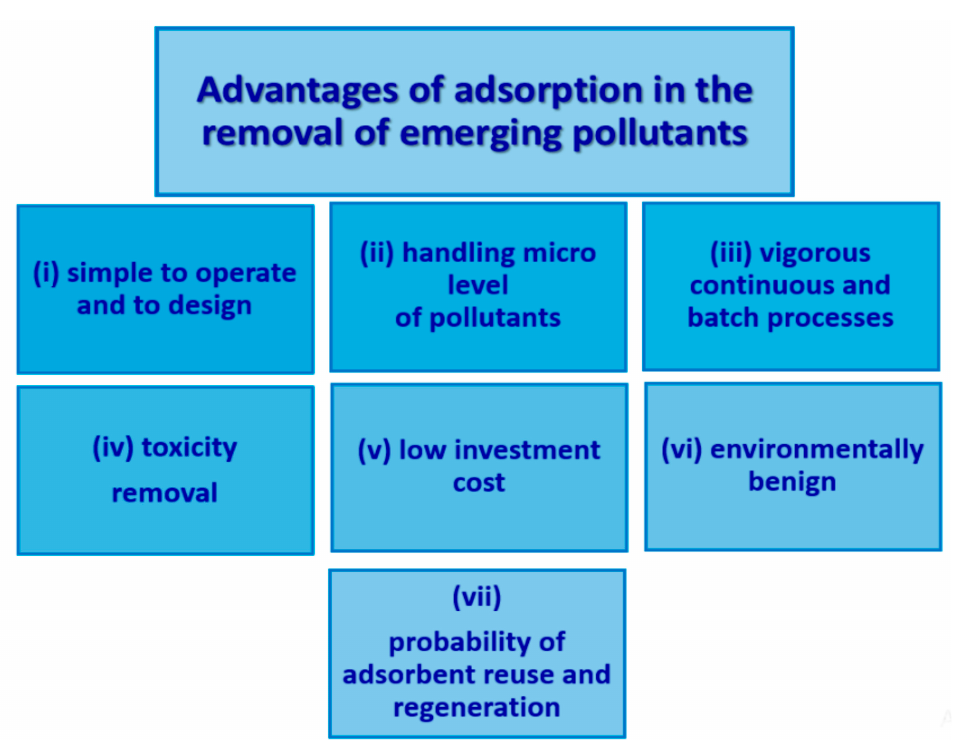
Figure 11. Some advantages of applying biosorption for the removal of emerging pollutants from liquid